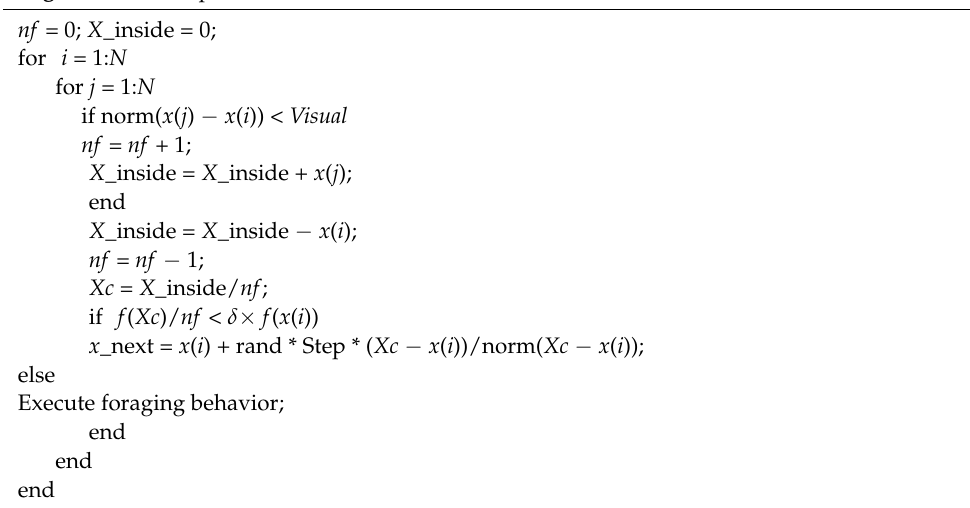
Algorithm 2 Group behavior Pseudo-code.